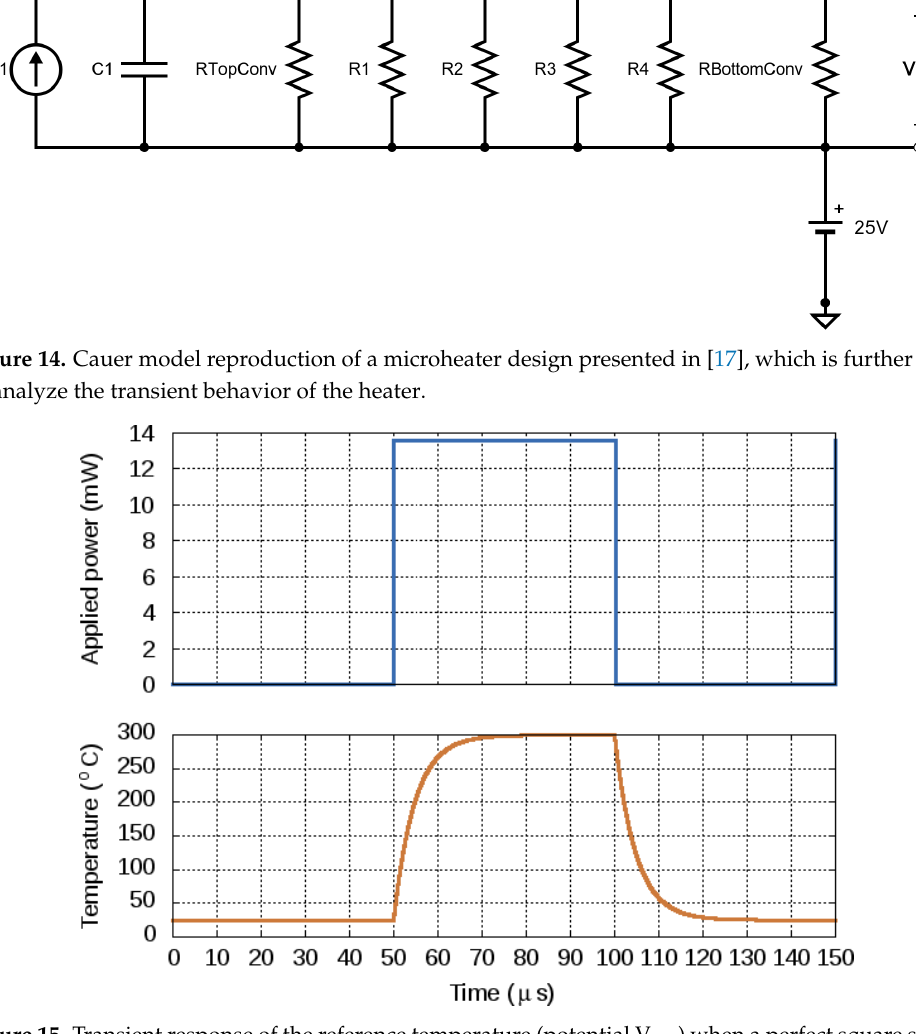
Figure 15. Transient response of the reference temperature (potential V Ref ) when a perfect square signal with an amplitude of 13.55 mW is applied at the power (current I1) source from Figure